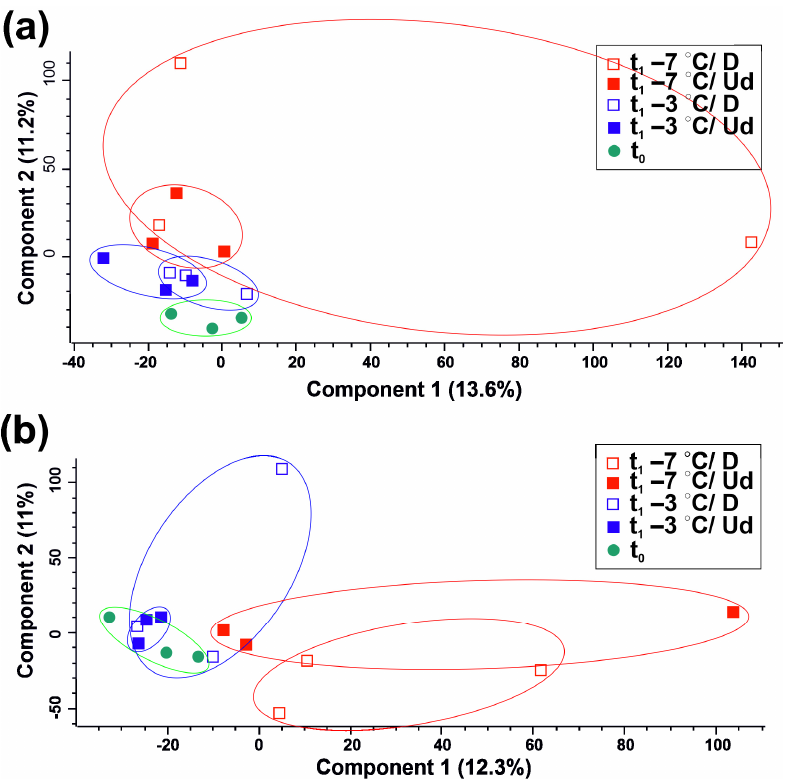
Figure 4. Principal component analysis of metabolites extracted from cotyledons ( a ) and embryonic axes ( b ). The score plots demonstrate the variation in the overall metabolome. Different symbols correspond to nonstored seeds (t 0 ), seeds stored at − 3 °C (t 1 − 3 °C) and seeds stored at − 7 °C (t 1 − 7 °C). The latter two involved undamaged (Ud) and damaged (D) classes indicated with open symbols.